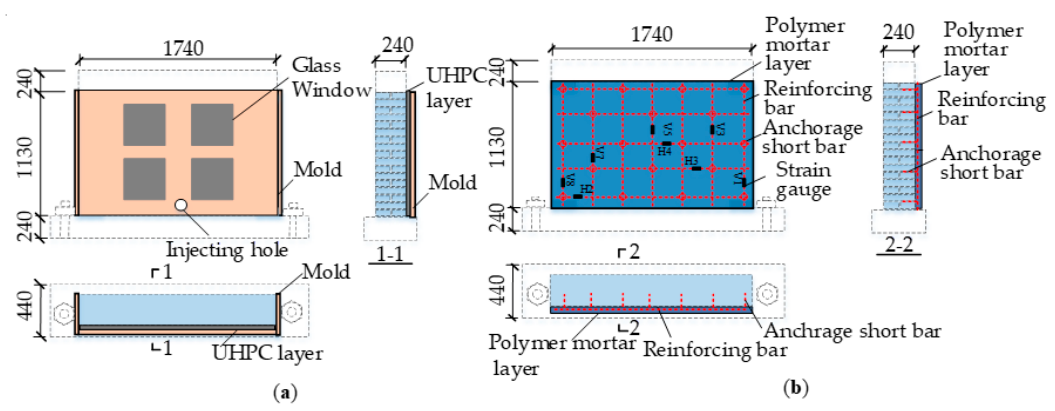
Figure 3. Construction of the strengthening layers: ( a ) The UHPClayer; ( b ) The reinforced polymer mortar layer.